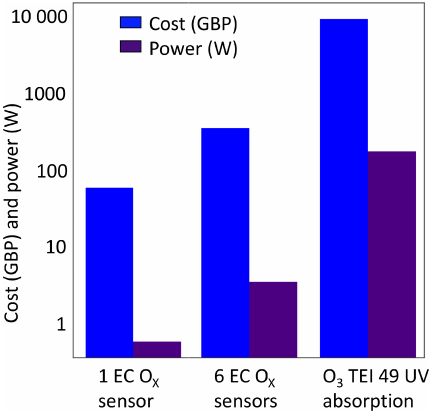
Figure 2. Cost (blue) and power (purple) competitiveness for a sin- gle O x EC sensor device, a clustered six-sensor device and a refer- ence UV ozone